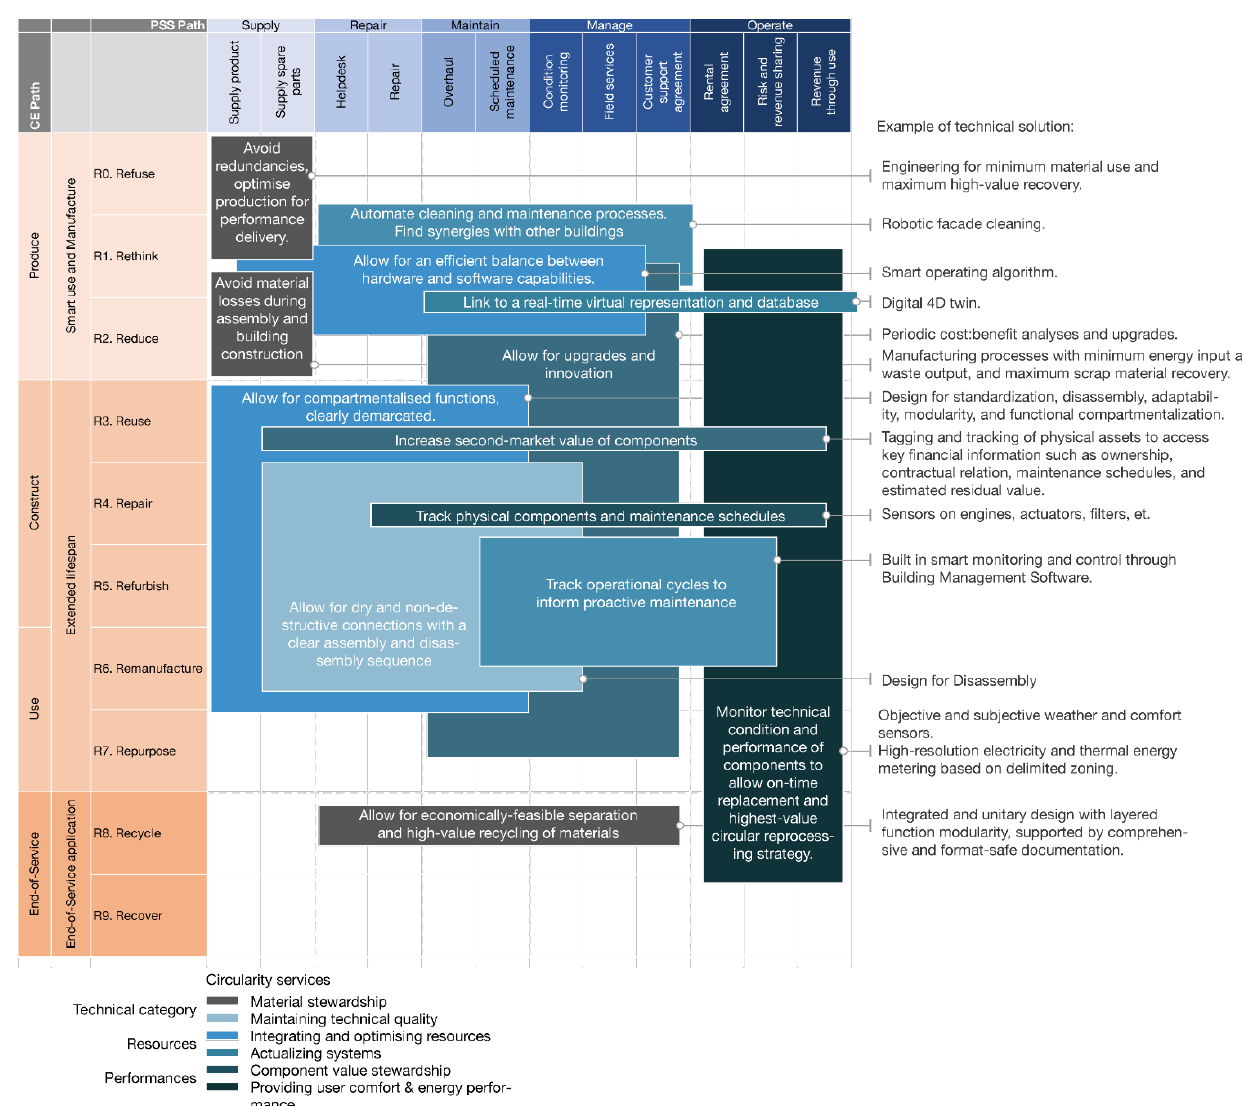
Figure 4. Selected new circularity-enabling façade functional requirements mapped according to the CE/PSS paths of the FaaS technological matrix. Examples of technical solutions to address these functional requirements are shown on the right.